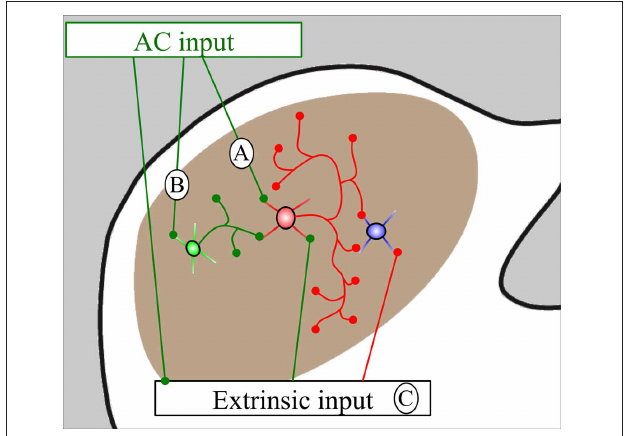
FIGURE 6 | Schematic diagram showing routes by which auditory cortical (AC) stimulation could generate inhibition in the IC. (A) Cortical stimulation activates GABAergic cells (red) that have extensive local collaterals and inhibit subsequent IC cells (blue). (B) Cortical stimulation activates glutamatergic cells (green) that activate GABAergic cells (red) which inhibit subsequent cells (blue). (C) Cortical stimulation activates cells extrinsic to the IC that directly or indirectly inhibit IC cells. This diagram is not subdivision specific and these effects could occur within or between the IC